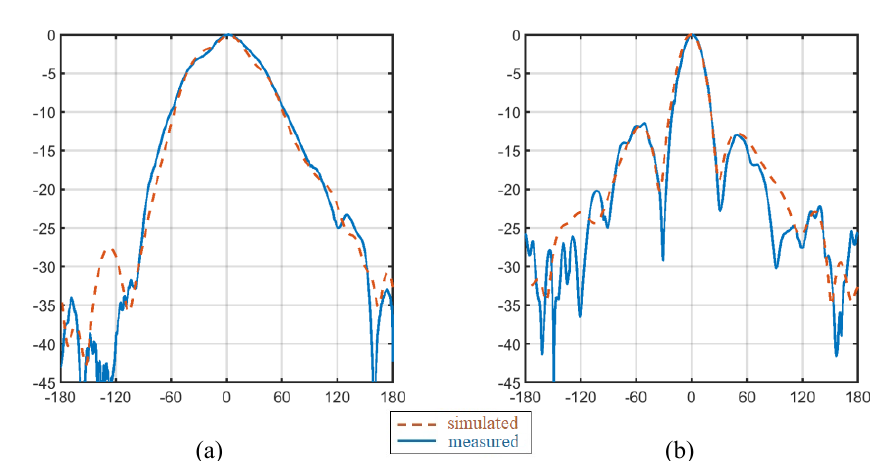
Fig. 4. Simulated and measured patterns at CF=2450 MHz a) horizontal plane b) vertical plane